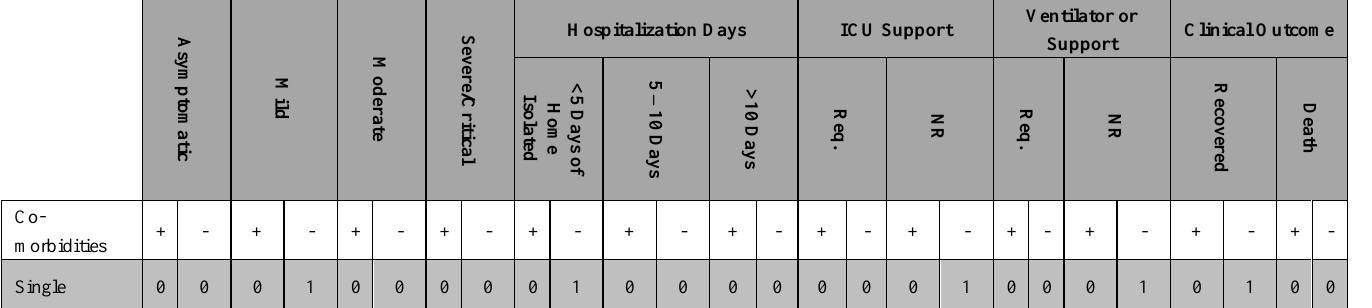
Table 6. Clinical severity with respect to vaccination and